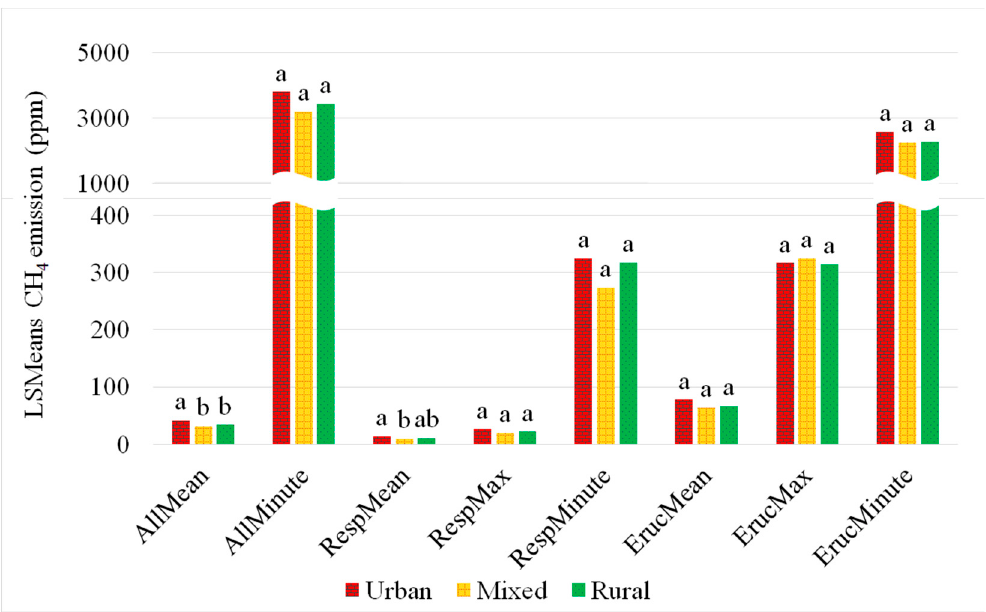
Figure 7. Least square means (LSMeans) for the methane traits across three location clusters classified by the survey stratification index. Different letters on bars indicate significant differences ( p -value < 0.05).